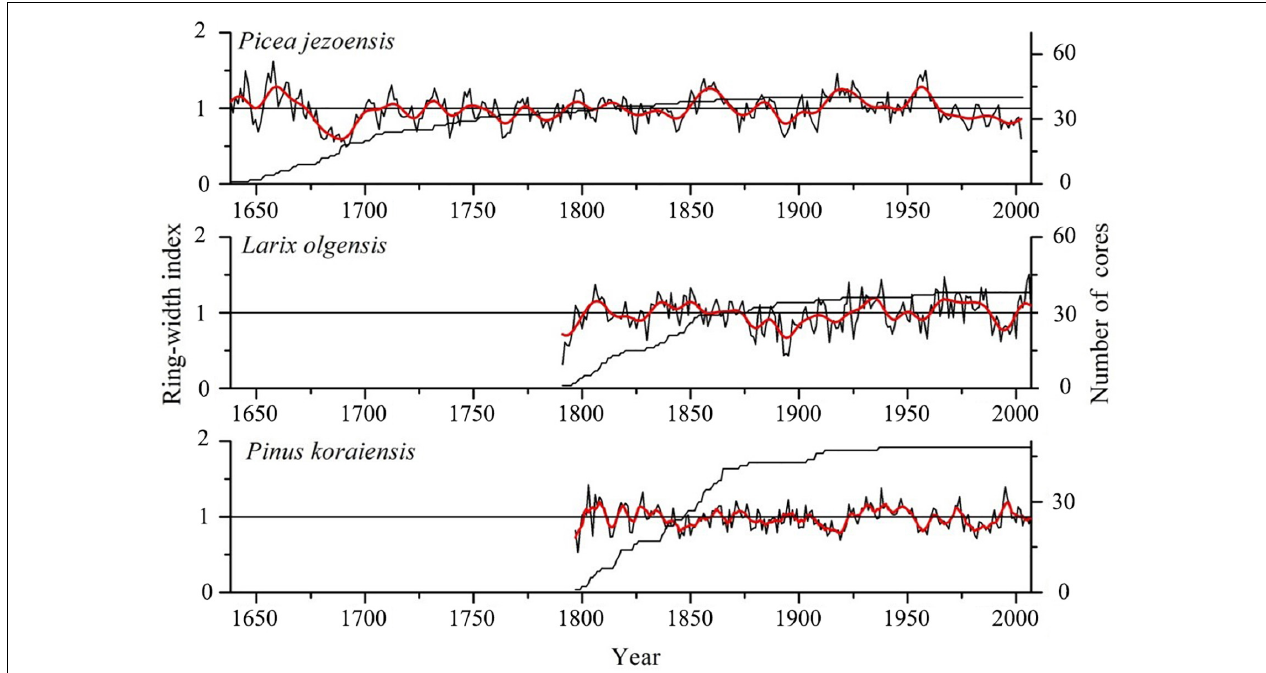
FIGURE 3 | Ring-width index series of the chronologies (left Y -axis) and numbers of tree-ring sample cores used in the chronology development (right Y -axis). The red lines represent the 5-year moving averages.